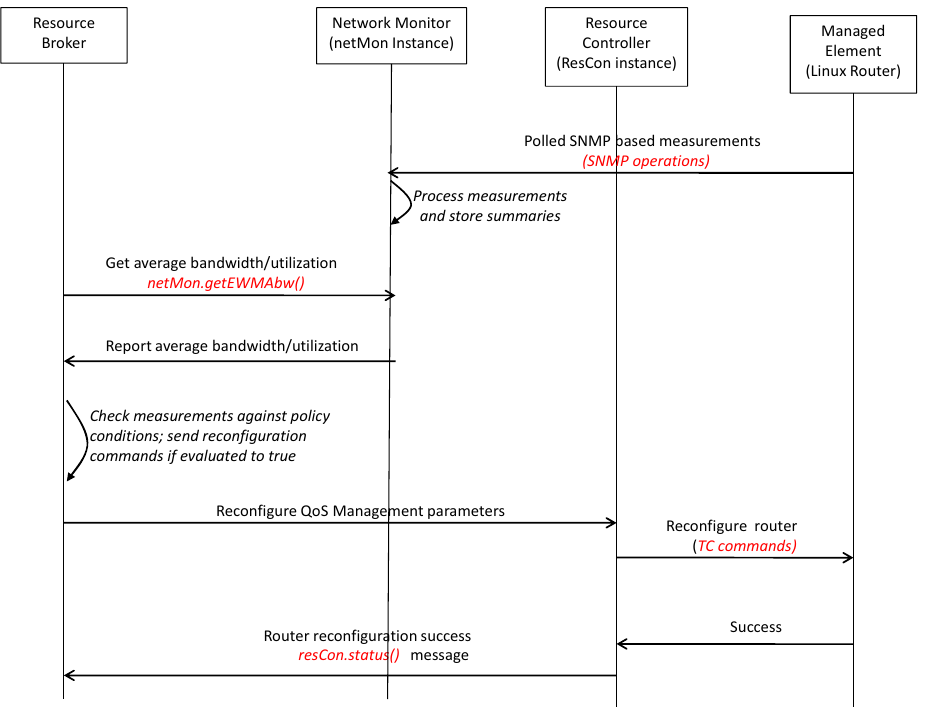
Figure 3. CNQF enabled adaptive measurement-based QoS management procedures